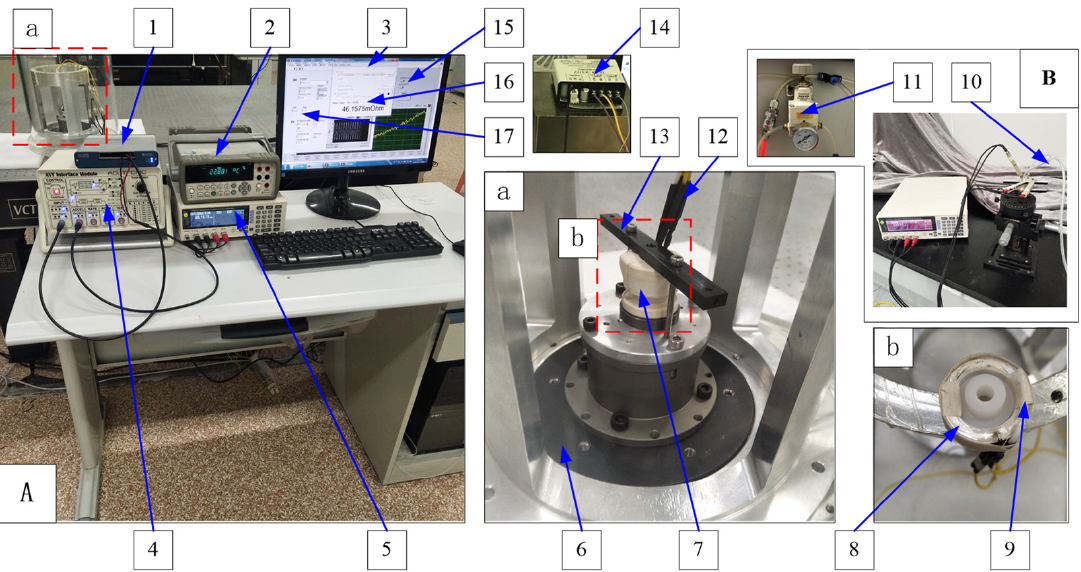
Figure 5. The experimental platform. A ‐ Static temperature experiment, different material experi ‐ ment and dynamic experiment; B ‐ Static pressure experiment. 1 ‐ Acquisition card; 2 ‐ Temperature monitor; 3 ‐ Industrial computer; 4 ‐ High frequency shaking table controller; 5 ‐ Resistance meter; 6 ‐ High frequency shaking table; 7 ‐ Heating device; 8 ‐ Fluid ring; 9 ‐ Temperature sensor; 10 ‐ Silica gel tube; 11 ‐ Pressure regulating valve; 12 ‐ Leading wire; 13 ‐ Installation tooling; 14 ‐ Temperature con ‐ trol module; 15 ‐ Temperature control and monitoring procedures; 16 ‐ Contact resistance acquisition program; 17 ‐ High frequency shake table control program.